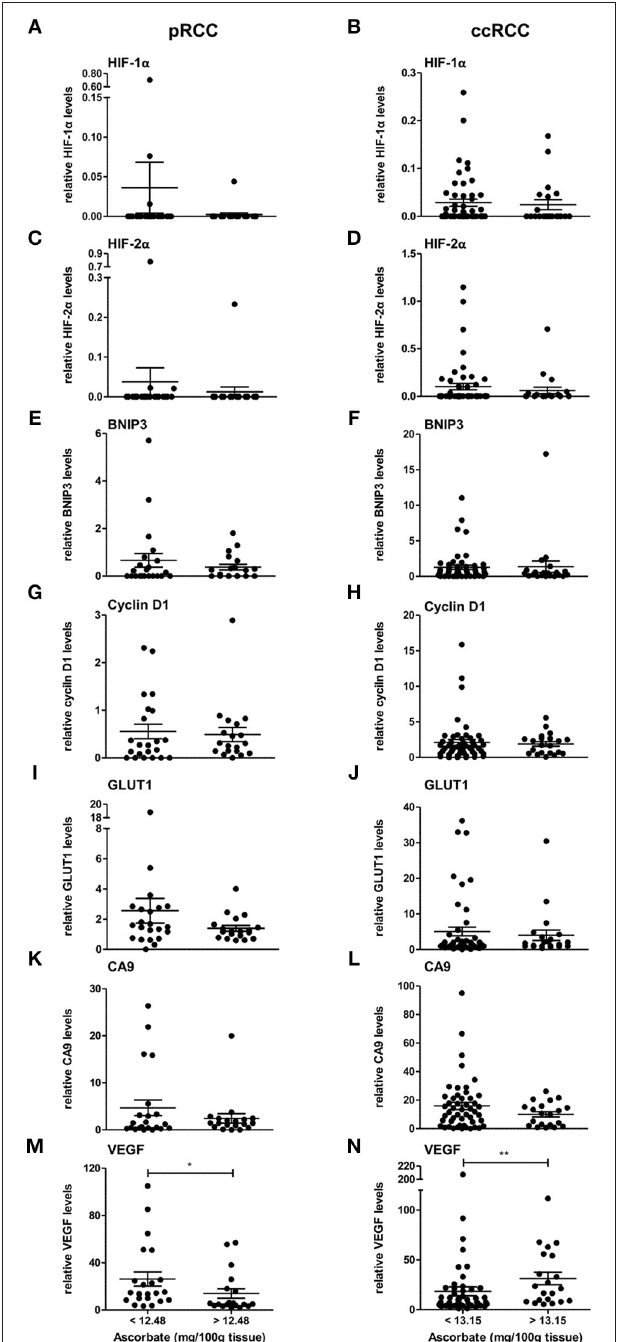
FIGURE 3 | Expression of HIF pathway proteins of pRCC and ccRCC tumors in relation to tissue ascorbate content. Bar plots show relative expression values of HIF-1 α (A,B) , HIF-2 α (C,D) , BNIP3 (E,F) , cyclin D1 (G,H) , GLUT1 (I,J) , CA9 (K,L), and VEGF (M,N) of pRCC ( n = 41, left panel) and ccRCC tumors ( n = 73, right panel) divided by the respective mean ascorbate content. There was no significant difference between the groups, except for VEGF. However, pRCC tumors with less tissue ascorbate levels tended to have increased HIF pathway protein levels. Differences between the groups where evaluated with the Mann-Whitney test. Data represent mean + SEM; * p < 0.05, ** p <